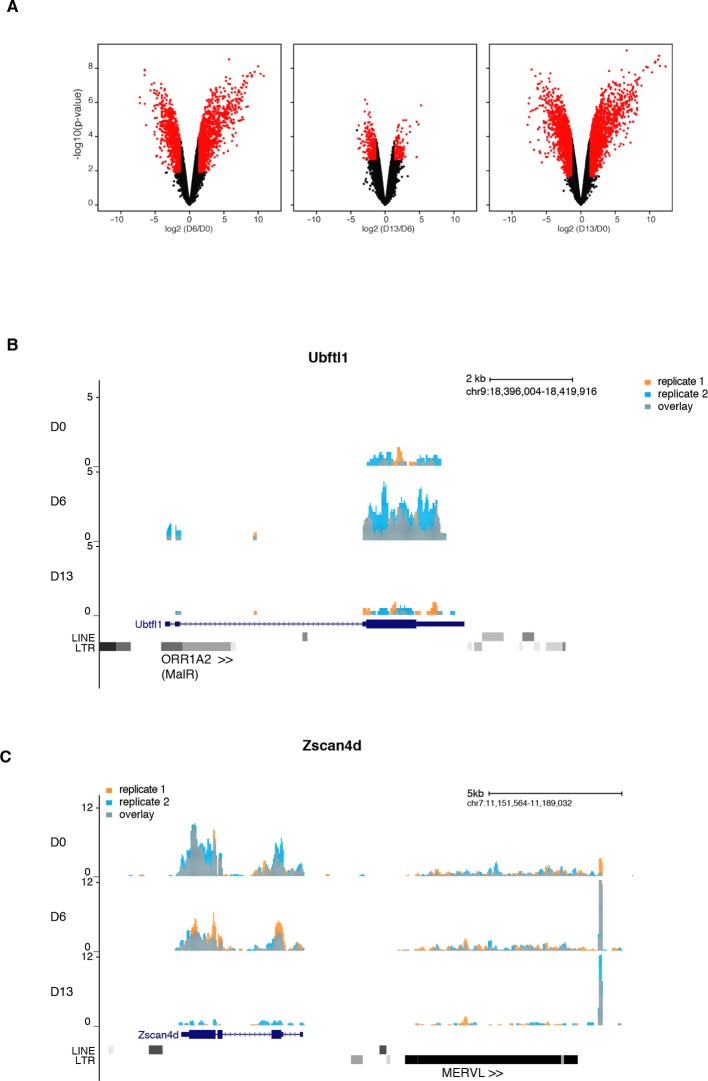
Gene expression analysis upon serum to 2i+vitC conversion.(A) Volcano plot representation of up- and down-regulated genes as measured by RNA-seq between D0 and D6, D6 and D13, and D0 and D13. Red dots indicate significantly misregulated genes (fold change >4 and p-value <0.01). (B) RNA-seq track showing a chimeric transcript between an ORR1A2 transposon and the 2-cell-specific Ubtfl1 gene, specifically expressed at D6. Data represent normalized read density (C) RNA-seq track showing uncoupled expression between the 2-cell-specific Zscan4d gene and the neighboring full-length MERVL transposon.